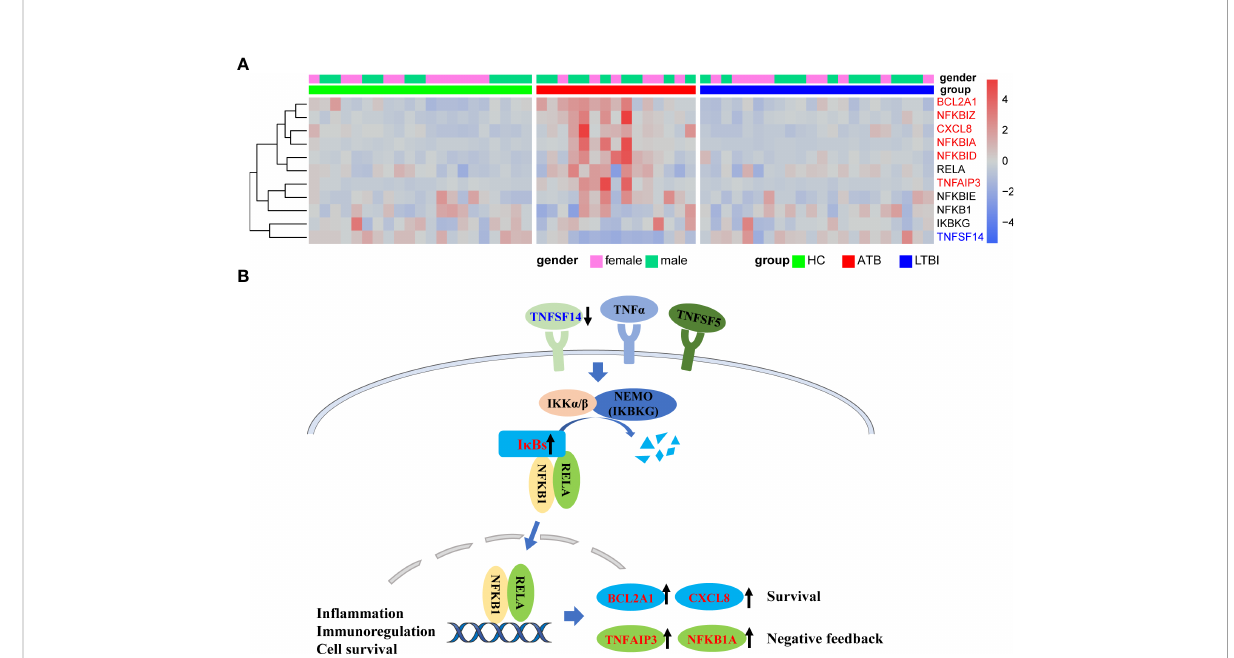
FIGURE 3 Upregulation of NFKB inhibitors in ATB might lead to inhibition of NFKB pathway activation. (A) Heat map of expression levels of some of the genes involved in the NFKB pathway. (B) Simpli fi ed schematic diagram of the canonical NFKB pathway. Downregulation of TNFSF14 results in insuf fi cient activation of pathway initiation, and the overexpression of I k Bs might inhibit nuclear translocation of NFkB dimers. Upregulation of the NFkB negative feedback regulator TNFAIP3 and NFKB1A further inhibited the pathway activation. Red font represents signi fi cantly upregulated genes in ATB, and blue font represents signi fi cantly downregulated genes in